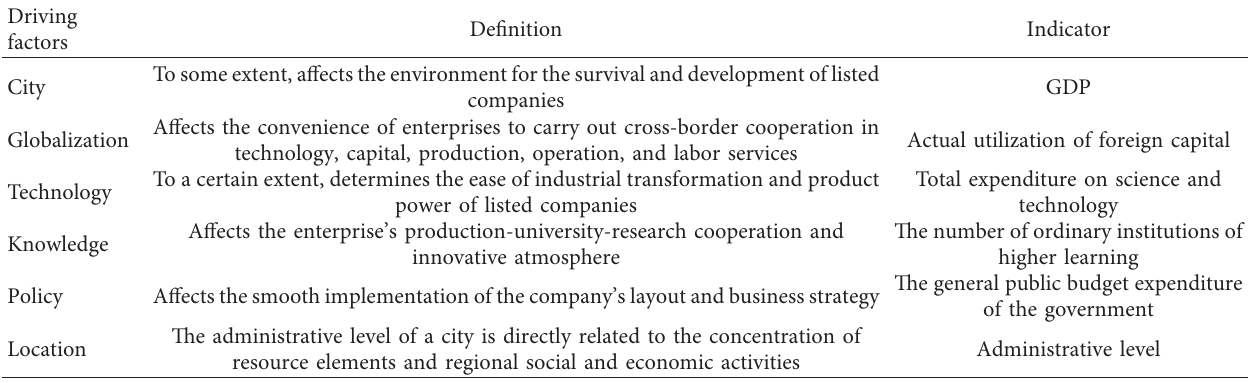
Table 2: Details of the driving factors used in the